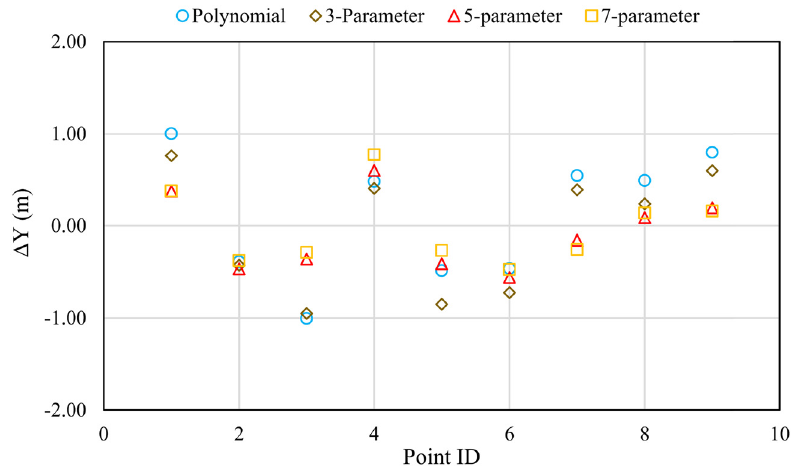
Figure 11: Di ff erences between observed and calculated dataset Y - coordinate values.